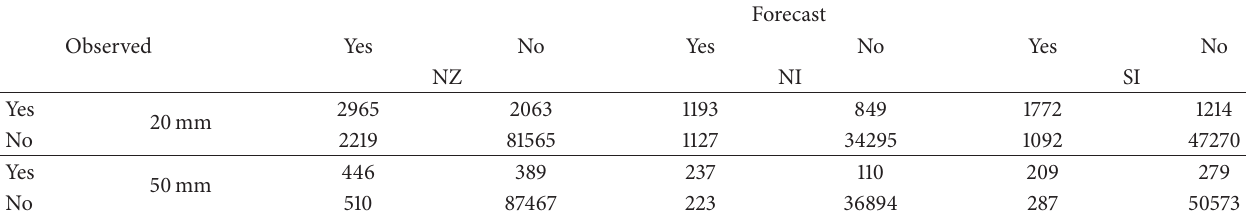
Table 3: Contingency table for the ensemble mean (MM) for daily rainfall thresholds of 20 mm and 50 mm for the whole country (NZ), the North Island (NI), and the South Island